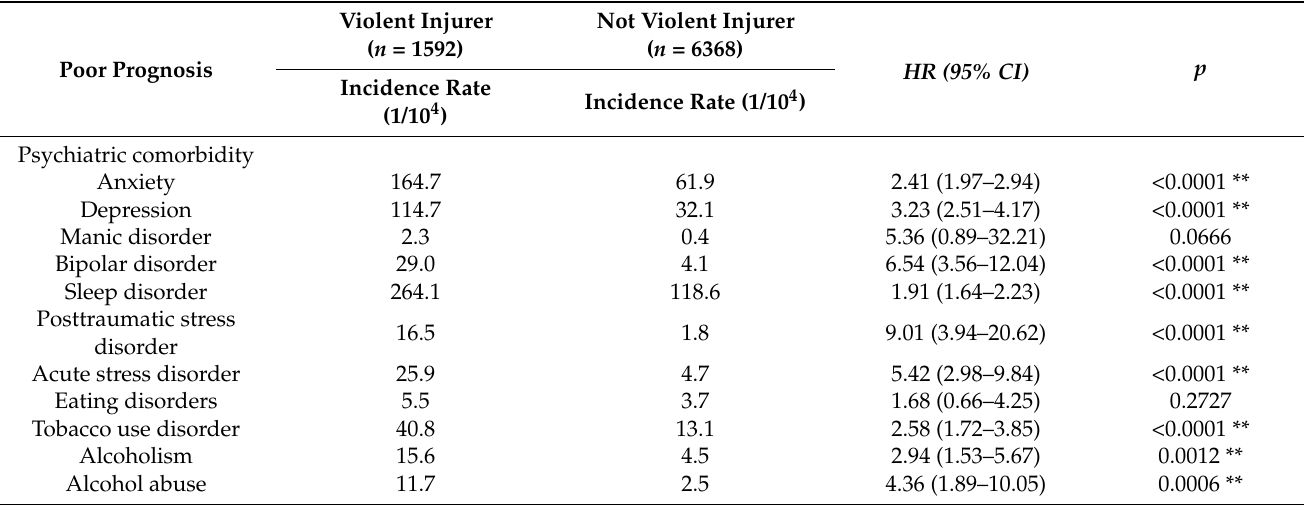
Table 2. Comparison of the risk of mental illness and poor prognosis between victims of violence and those without violence (children and